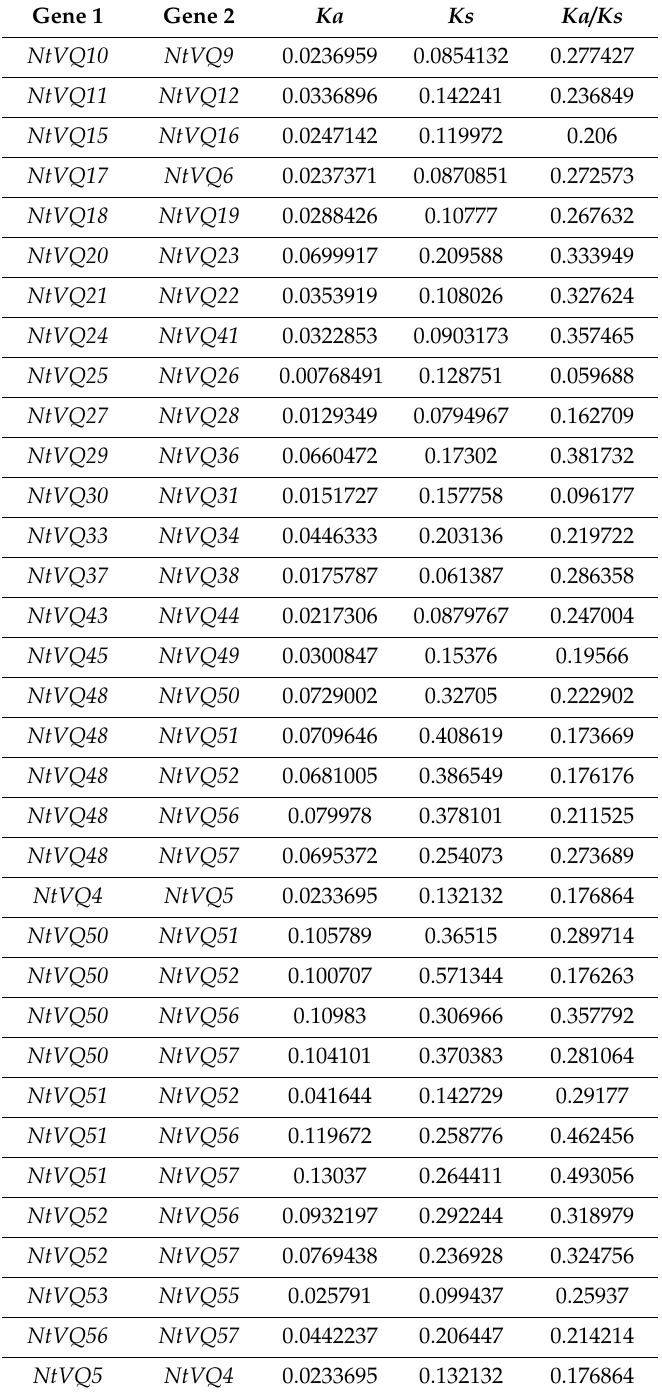
Table 2. Ka , Ks , and Ka / Ks values calculated for paralogous NtVQ gene